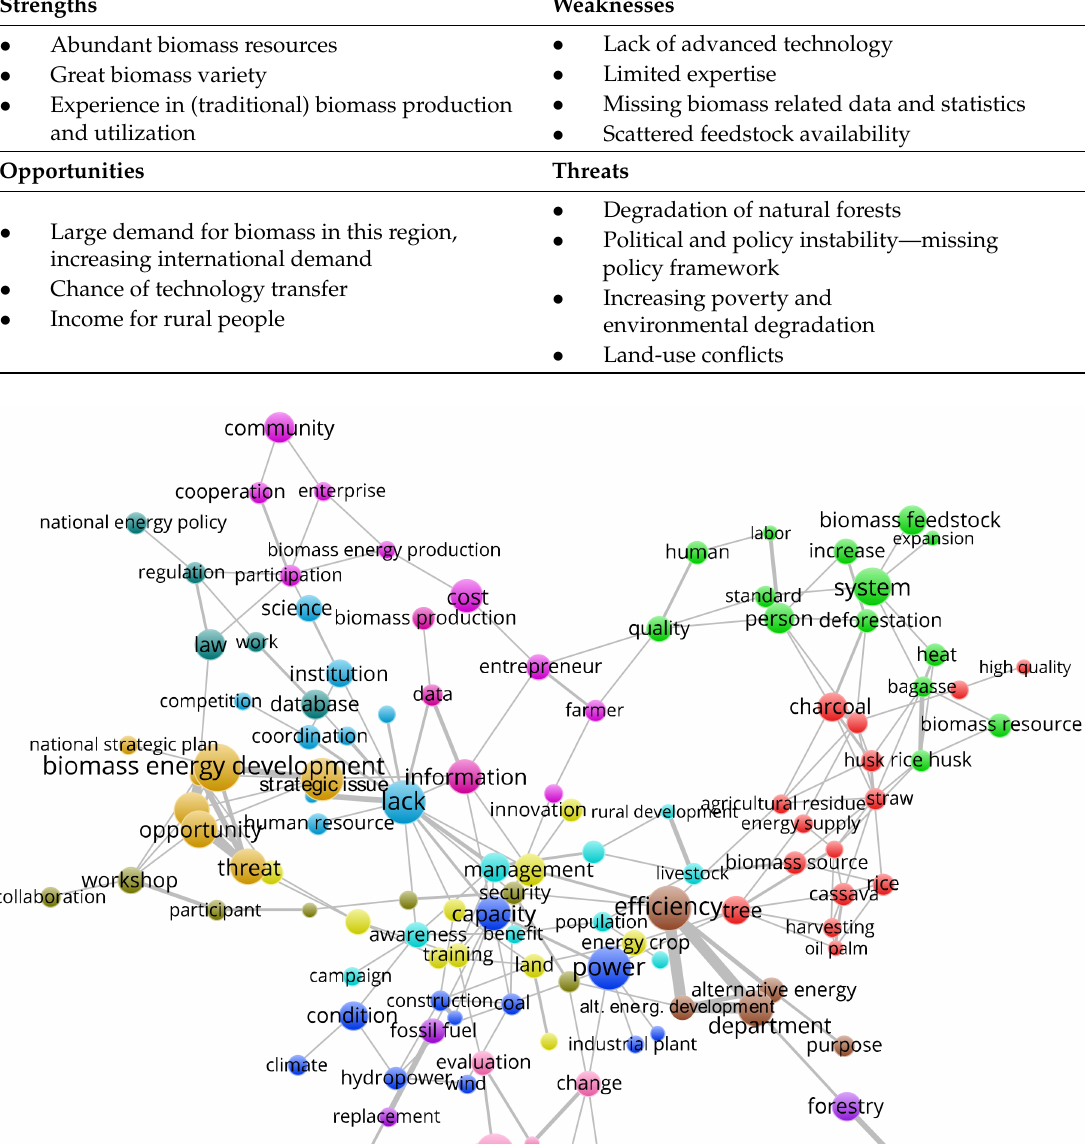
Table 3. SWOT meta-analysis of all NBDPs. Source: [31].